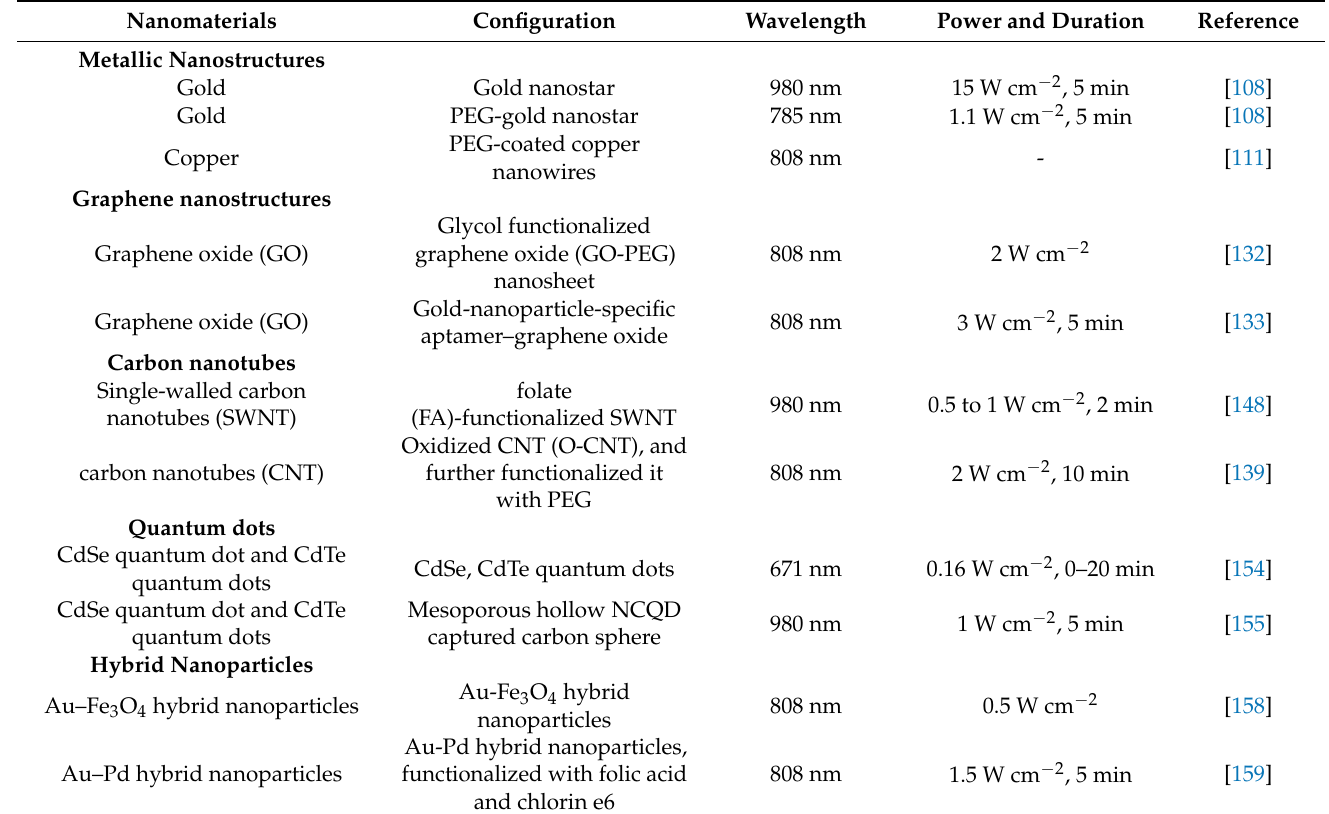
Table 1. Potential nanomaterials for photothermal